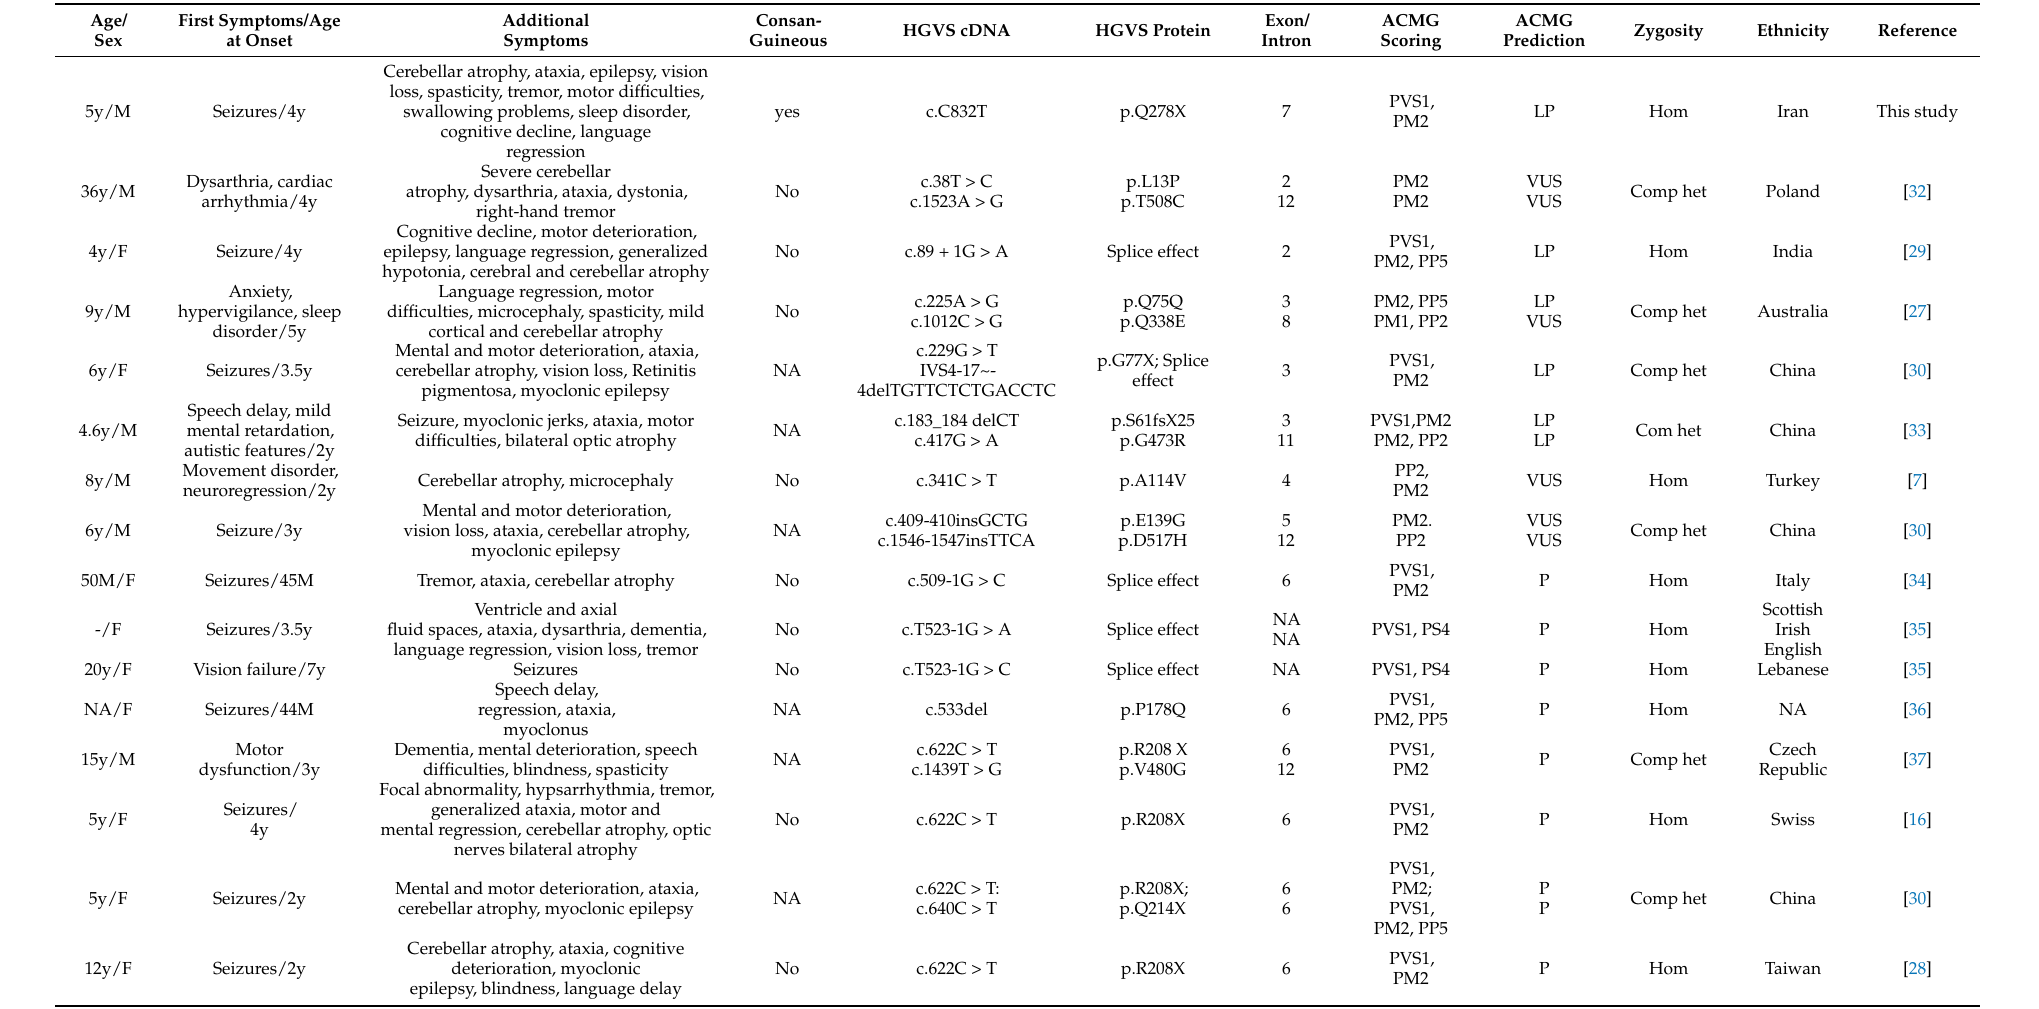
Table 1. Pathogenic TPP1 variants and associated clinical details (literature